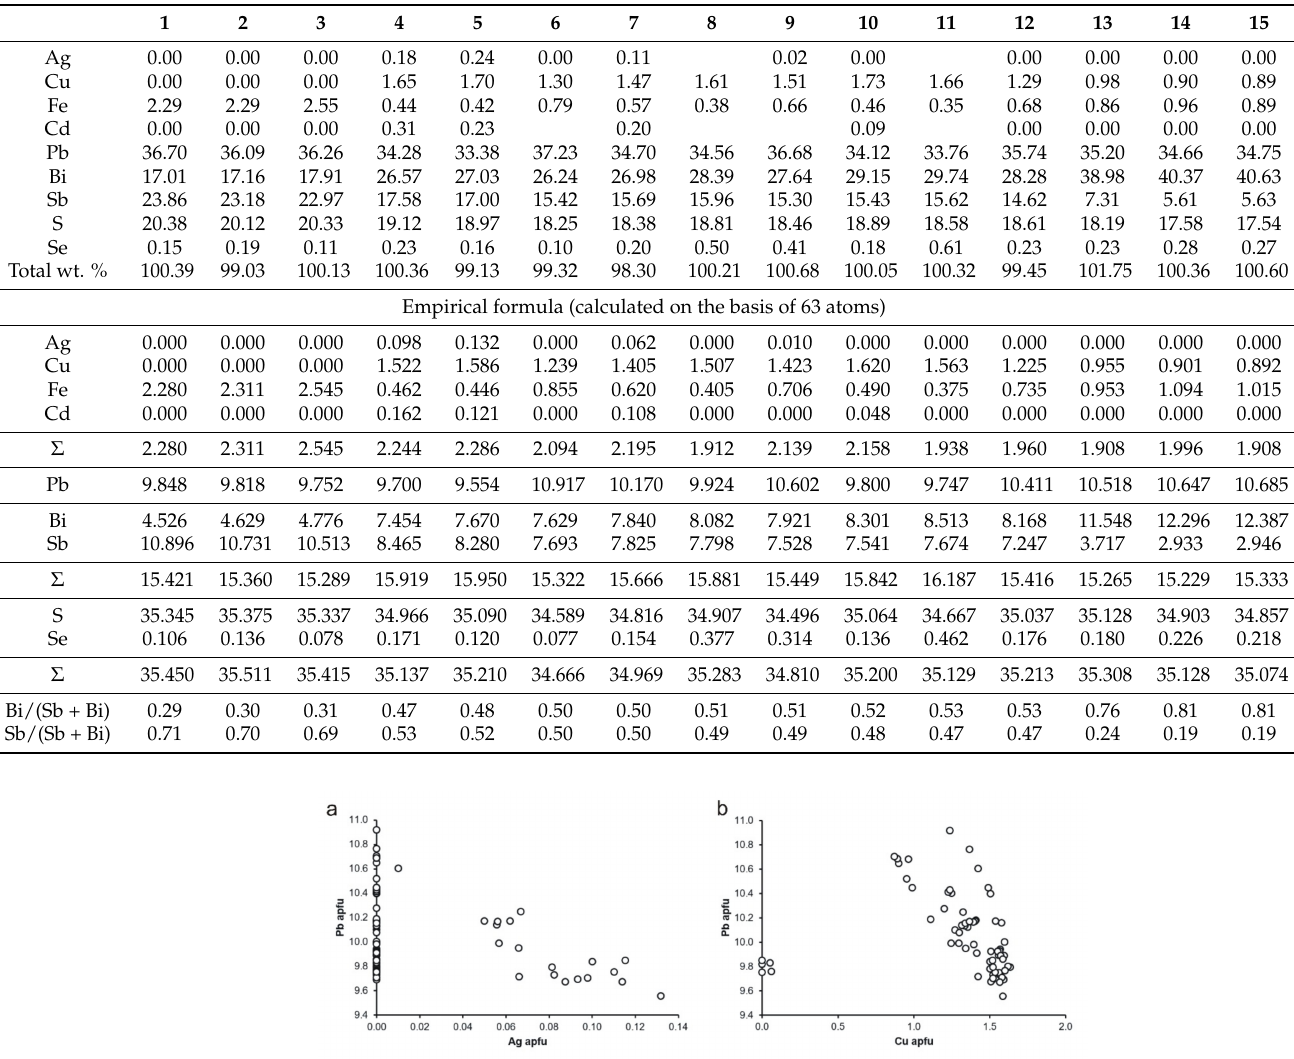
Table 10. Representative WDS microanalyses of minerals of the kobellite–tintinaite series from ˇCuˇcma (Majersk á valley).